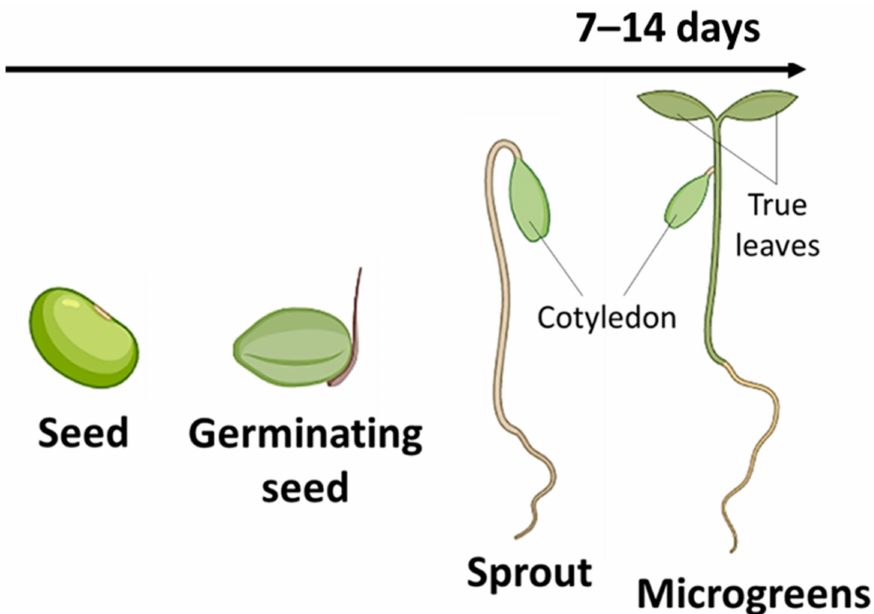
Figure 2. Germination of seed to